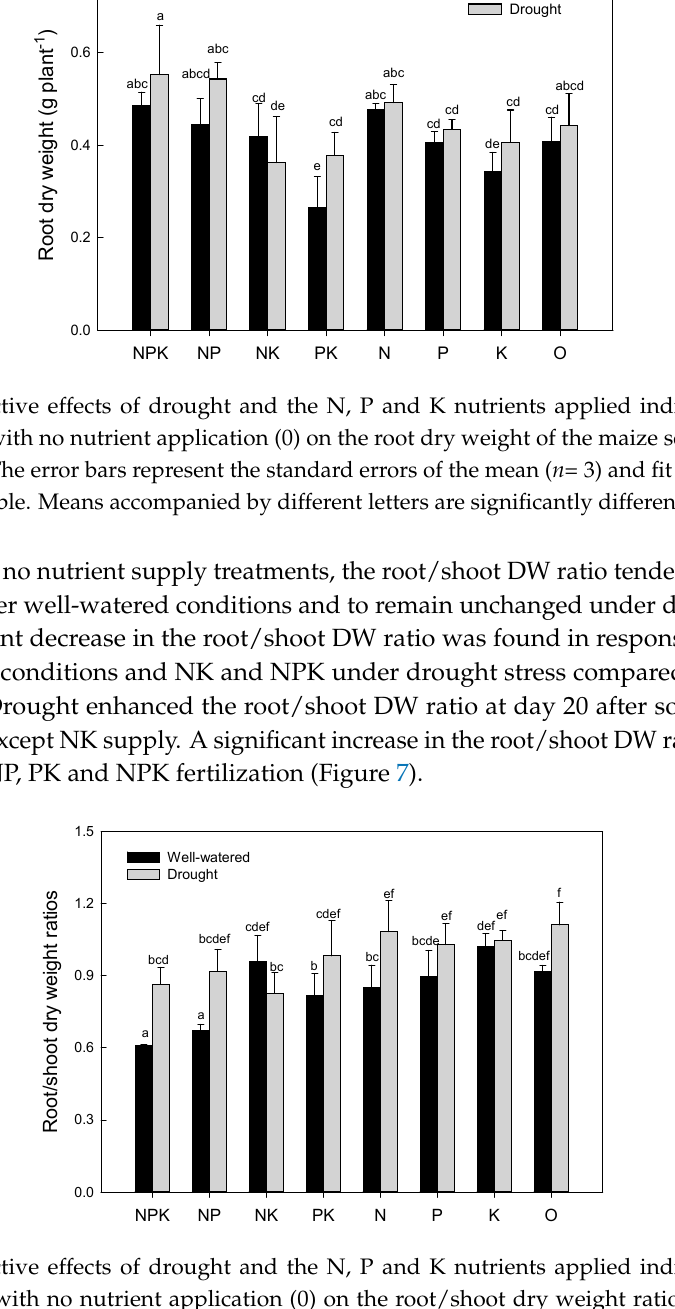
Figure 5. Interactive effects of drought and the N, P and K nutrients applied individually or in combination, or with no nutrient application (0) on the shoot water content of the maize seedlings at day 20 after sowing. The error bars represent the standard errors of the mean ( n = 3) and fit within the plot symbol if not visible. Means accompanied by different letters are significantly different at p < 0.05.